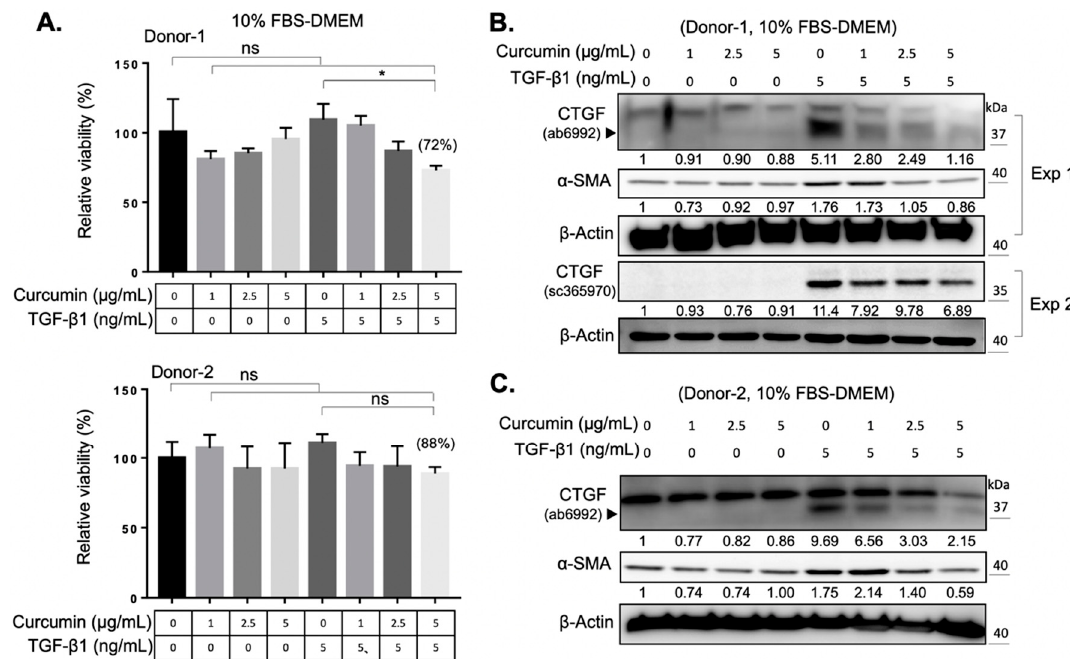
Figure 2. Curcumin suppresses the TGF- β 1-activated myofibroblast differentiation. ( A ) The viability of orbital fibroblasts was measured after treatment with the indicated doses of curcumin and TGF- β 1. Cells were seeded in 10% FBS-containing medium overnight and treated with the indicated dose of curcumin, TGF- β 1 or both for an additional 24 h. The relative viability of orbital fibroblasts after treatment with 5 μ g/mL of curcumin and 5 ng/mL of TGF- β 1 is indicated in brackets. Data are expressed as the mean ± SD ( n = 3). ns, not significant. *, p < 0.05. ( B , C ) Western blots showed the expression levels of CTGF and α -SMA at indicated culture conditions of the orbital fibroblasts from Donor-1 ( B ) and Donor-2 ( C ). The relative intensity value to corresponding controls is indicated below. Exp 1: experiment 1; Exp 2: experiment 2.